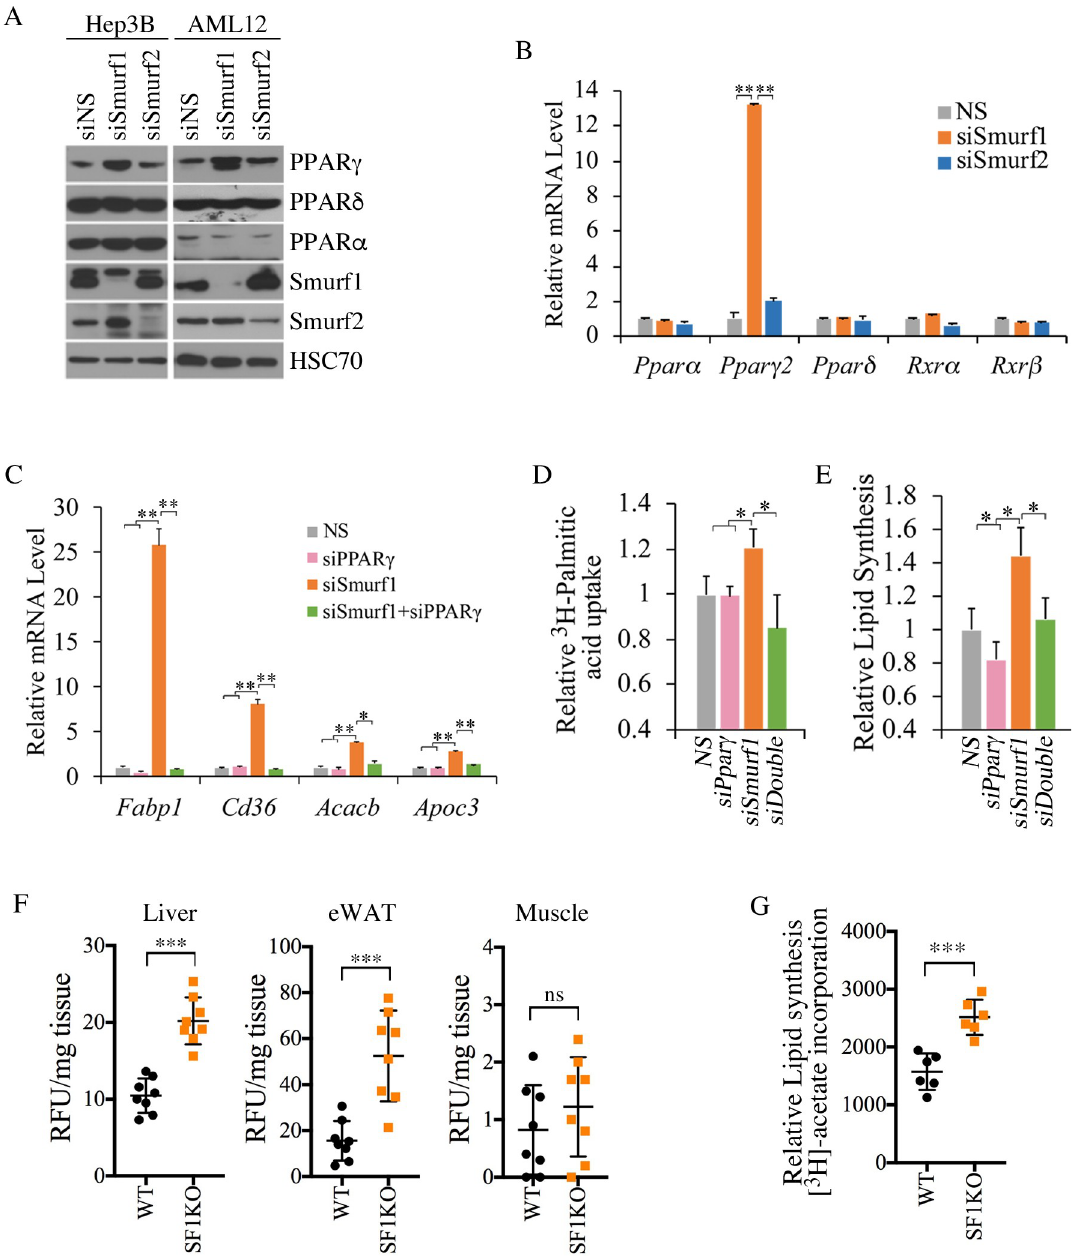
Fig 4. Smurf1 regulates fatty acid uptake and lipid synthesis through PPAR γ . (A) Western blots showing that knockdown of Smurf1 but not Smurf2 in Hep3B and AML12 cells increased PPAR γ protein level. (B) qRT-PCR analyses showing that knockdown of Smurf1 but not Smurf2 increased Ppar γ mRNA level in AML12 cells. (C) qRT-PCR analyses showing that knockdown of Smurf1 in AML12 cells increased expression of Fabp1 , Cd36 , Acacb , and Apoc3 in a PPAR γ -dependent manner. (D) Fatty acid uptake in AML12 cells as measured by 3 H-palmitate incorporation ( n = 3). (E) Lipid synthesis in AML12 cells as measured by incorporation of 3 H- acetate into lipid ( n = 3). (F) In vivo fatty acid uptake after intraperitoneal injection of BODIPY-FL-C16. The BODIPY-FL-C16 accumulation in the liver, epididymal WAT, and skeletal muscle was normalized to tissue weight ( n = 8 per group). (G) Lipogenesis in primary hepatocytes as measured by the incorporation of 3 H-acetate into lipid ( n = 6 per group). Data are presented as mean ± SD; statistical significance of difference is indicated as � p < 0.05, �� p < 0.01, ��� p < 0.001. Original raw data can be found in S1 Data. BODIPY-FL-C16, 4,4-Difluoro-5,7-Dimethyl-4-Bora-3a,4a-Diaza- s -Indacene-3-Hexadecanoic Acid; eWAT, epididymal WAT; HSC70, heat shock cognate 71 kDa protein; NS, non-silencing control; PPAR, peroxisome proliferator-activated receptor; qRT-PCR, quantitative real-time PCR; RFU, relative fluorescence units; Rxr, retinoid x receptor; SF1KO, Smurf1 KO; siNS, non-silencing control siRNA; Smurf, Smad ubiquitin regulatory factor; WAT, white adipose tissue; WT, wild-type.